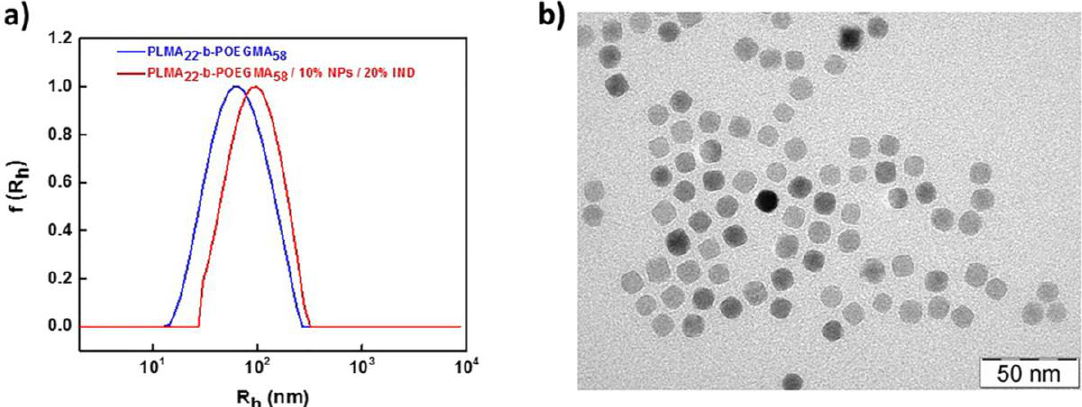
Figure 6. ( a ) Comparative size distribution graphs from CONTIN analysis before and after the